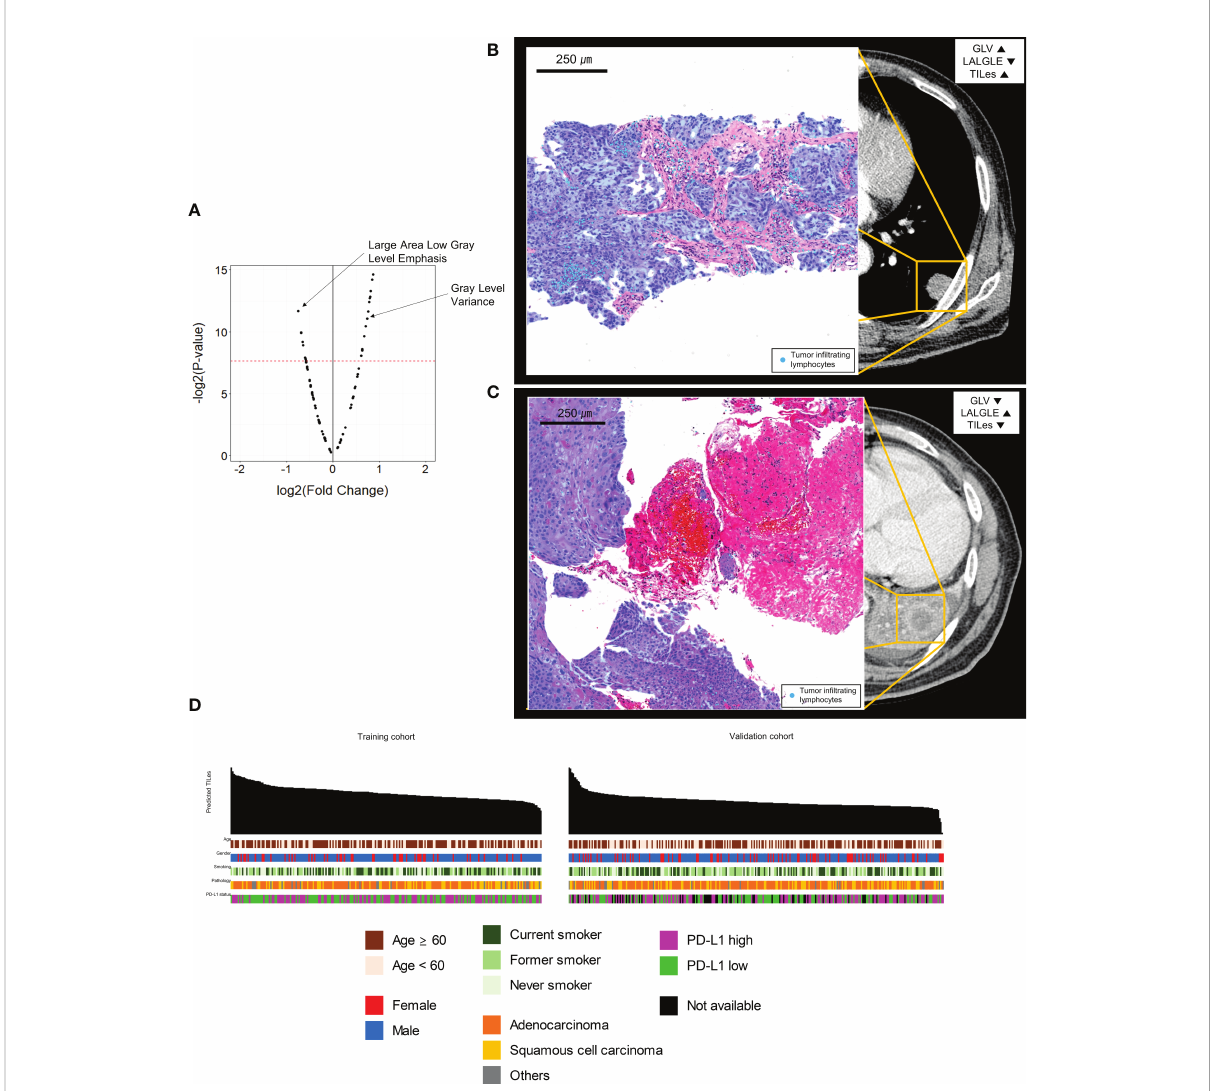
FIGURE 2 Features associated with tumor in fi ltrating lymphocyte enrichment score (TILes). (A) Volcano plot showing the features associated with TILes. Red horizontal dashed line represents a p-value of 0.005. The points representing Gray Level Variance (GLV) and Large Area Low Gray Level Emphasis (LALGLE) are indicated by arrows. (B) CT image and H&E slide example of patient with high GLV and low LALGLE. The blue areas in the H&E slide represent cancer epithelium; the skyblue dots in the H&E slide represent TILs. (C) CT image and H&E slide example of patient with low GLV and high LALGLE. The blue areas in the H&E slide represent cancer epithelium; the skyblue dots in the H&E slide represent TILs. (D) Bar plots and heatmap showing the distribution of predicted TILes and demographics in the training cohort and validation cohort. The patients are arranged by predicted TILes values in decreasing order in each